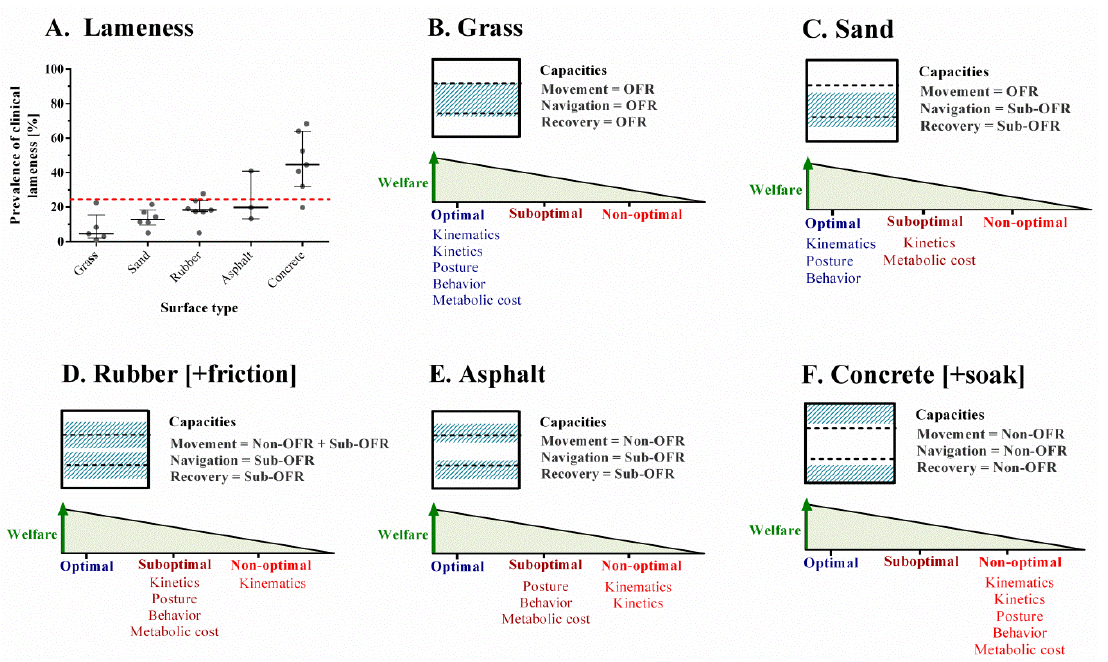
Figure 4. Integrative analysis of functional ranges for postural, behavioral, and locomotion indicators in dairy cows according to different types of surfaces evaluated. ( A ). A graphical representation of the lameness prevalence for each type of surface, as found in the literature, using a 95% confidence interval plot; average seen as a bold line. Points represent the result recorded for each study (see Table S1). The red dotted line represents the average prevalence of reported lameness [24,36]. Welfare status diagrams for: ( B ). grass, ( C ). sand, ( D ). rubber plus friction increment, ( E ). asphalt, ( F ). concrete plus soak increment. The optimal functional range is represented by the dashed lines and the functional range of each surface by the hatched area. The profile for the movement indicators for each type of soil is shown below each scheme. OFR: optimal functional range; sub-OFR: suboptimal functional range; non-OFR: non-optimal functional range.